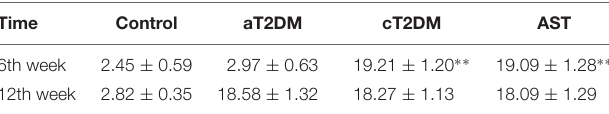
TABLE 1 | Effect of AST on the blood glucose level in each group (unit: mmol/l).